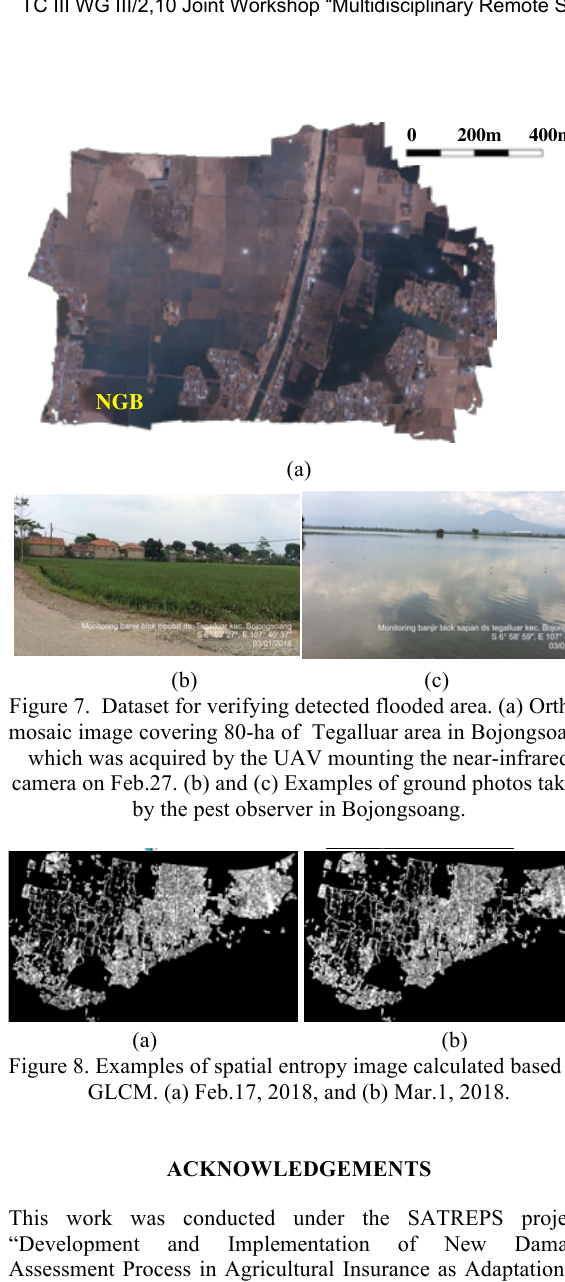
Figure 8. Examples of spatial entropy image calculated based on GLCM. (a) Feb.17, 2018, and (b) Mar.1,